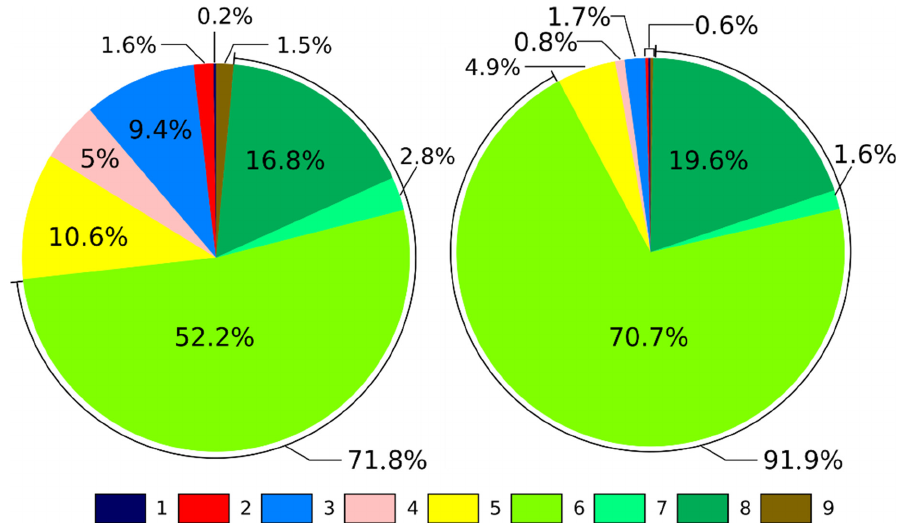
Figure 3. Land use and land cover (LULC) of the research site ( left diagram) and the landslides ( right diagram). 1 = water; 2 = urban and built ‐ up; 3 = rice paddy; 4 = crops; 5 = grassland; 6 = decid ‐ uous broadleaf forest; 7 = deciduous needle ‐ leaf forest; 8 = evergreen broadleaf forest; 9 = bare land (data source: HRLULC ver. 16.09 [82]).